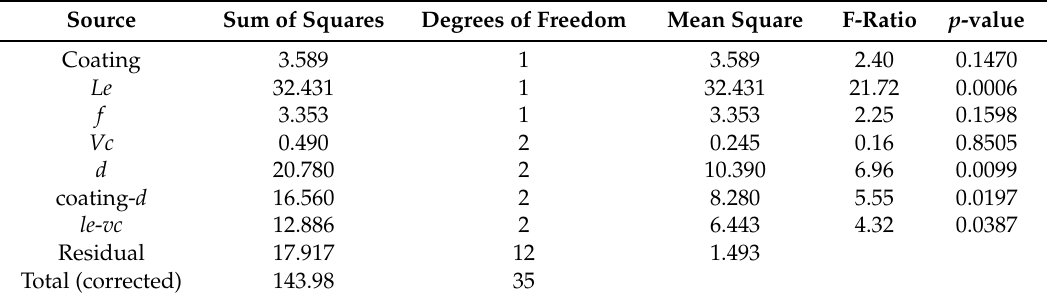
Table 7. ANOVA for the S/N ratio (Energy/MRR).